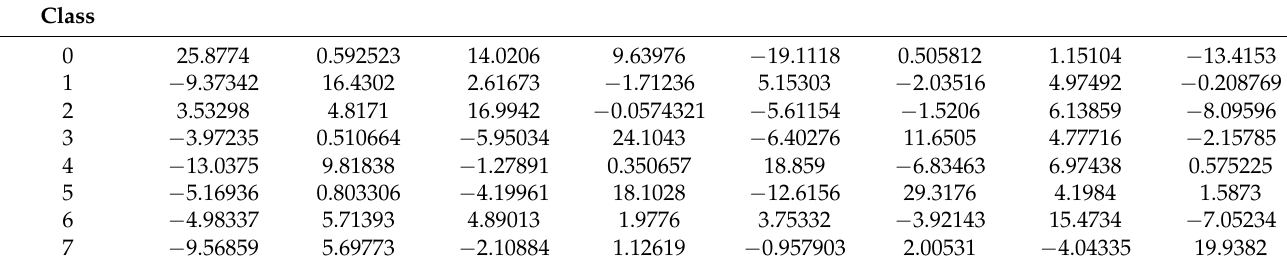
Table 3. Matrix M shows the mean values of AVs in each